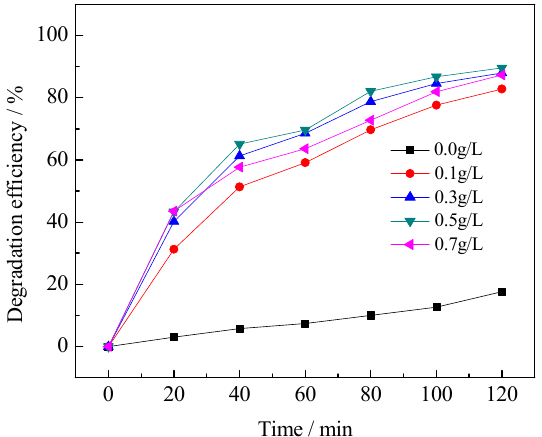
Figure 8. Effect of La/TiO 2 dosage on photocatalytic degradation of benzohydroxamic acid. Reaction conditions: C (benzohydroxamic acid) = 30 mg·L − 1 , 300 W mercury lamp, 0.75% La/TiO 2 , calcined temperature at 500 °C.